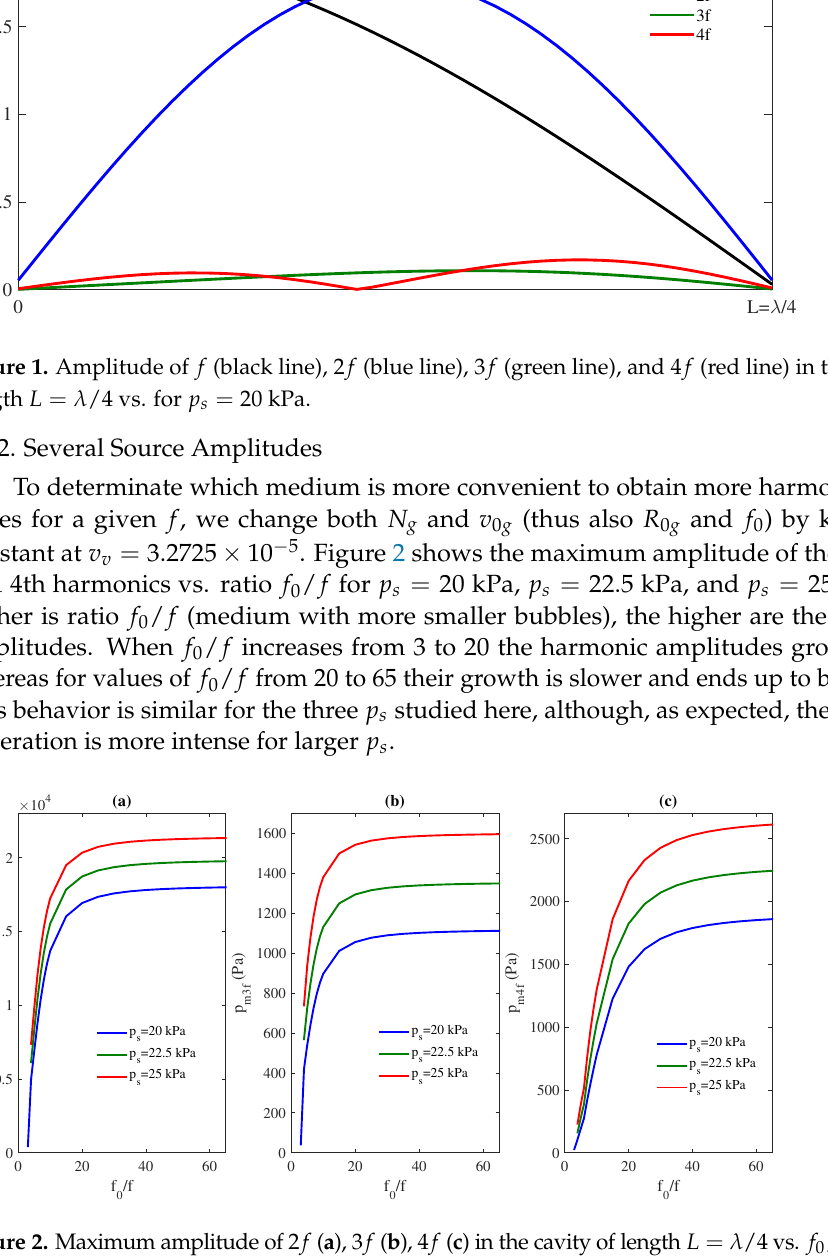
Figure 2. Maximum amplitude of 2 f ( a ), 3 f ( b ), 4 f ( c ) in the cavity of length L = λ /4 vs. f 0 / f , for three different source amplitudes p s = 20 kPa (blue line), p s = 22.5 kPa (green line), and p s = 25 kPa (red